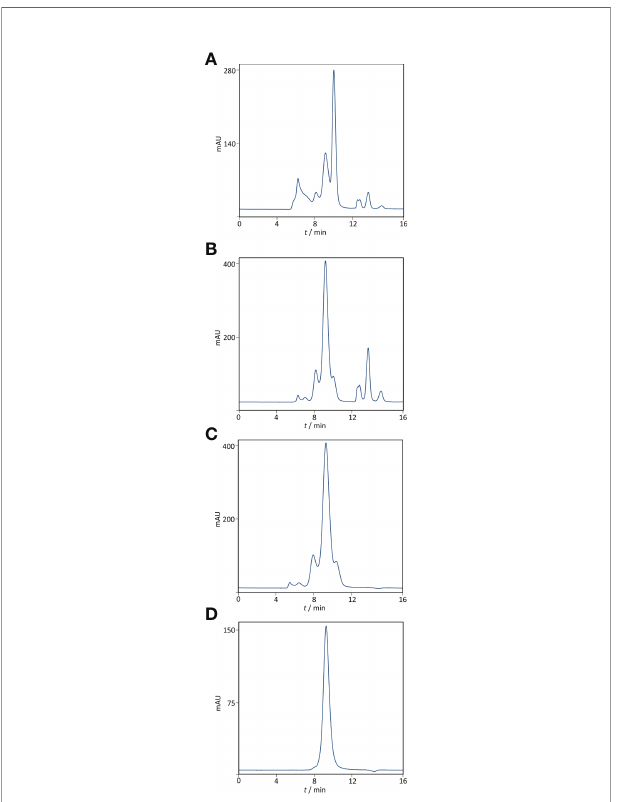
FIGURE 2 | Purity pro fi ling by size-exclusion chromatography. Analysis was performed on TSK-Gel G3000SWXL column (7.8 × 300 mm) with 0.1 M phosphate-sulphate running buffer, pH 6.6, at a fl ow rate of 1 mL min -1 . Heat-treated COVID-19 convalescent plasma (A) . IgG fraction obtained by caprylic acid precipitation before (B) and after dia fi ltration using a 100 kDa membrane (C) . Final product — fl ow-through fraction from anion-exchange chromatography performed at pH 5.0 ( D ). Detection: UV at 280 nm.